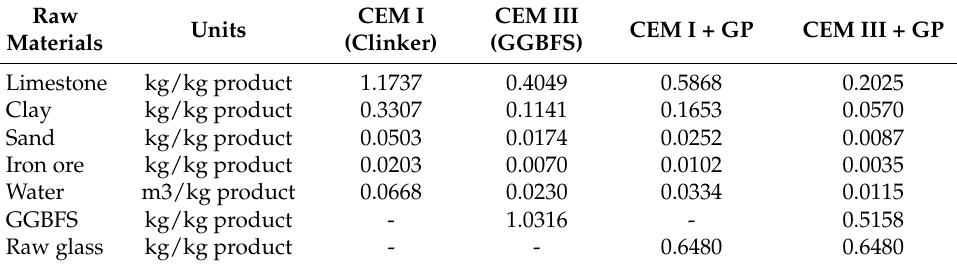
Table 4. Cement regulations following European Standard (EN 197-1) [59].